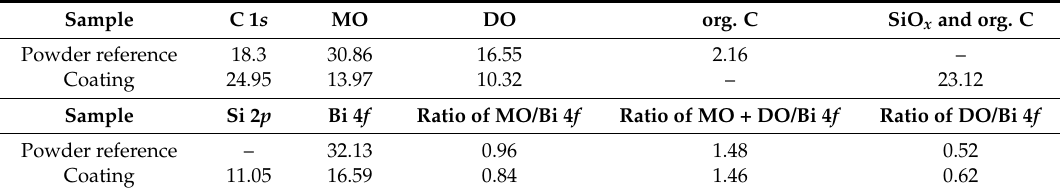
Table 1. Atomic concentration of the powder reference and the coating in at.% with a split oxygen peak and the ratio of metal oxide/bismuth, sum of metal oxide and defective oxide/bismuth and defective oxide/bismuth.